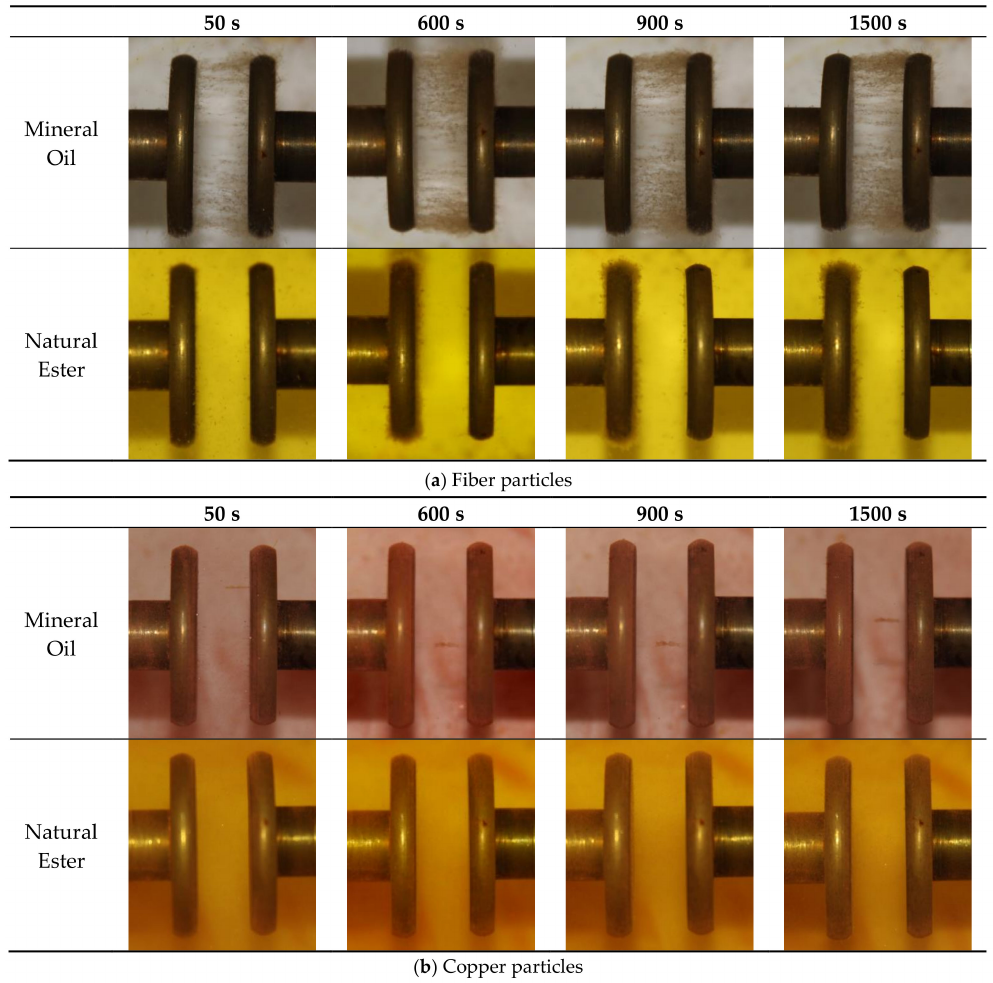
Figure 3. Dynamic motion of ( a ) fiber particles and ( b ) copper particles in insulating oil under